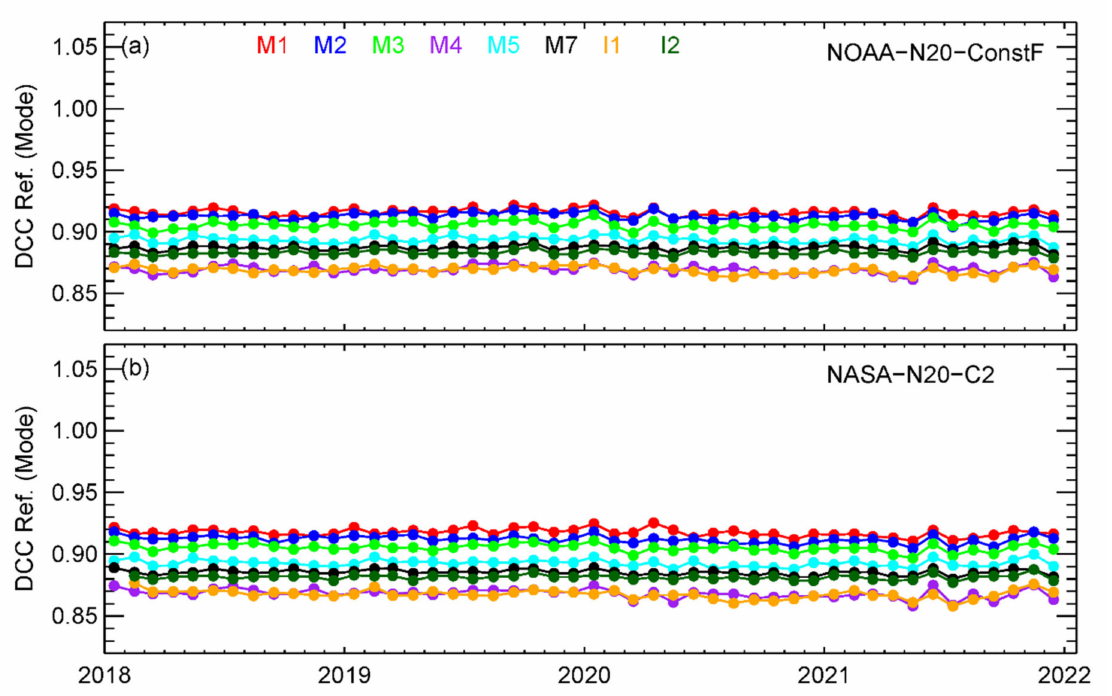
Figure 5. NOAA-20 VIIRS VIS/NIR bands monthly DCC time series: ( a ) NOAA-N20-ConstF and ( b )